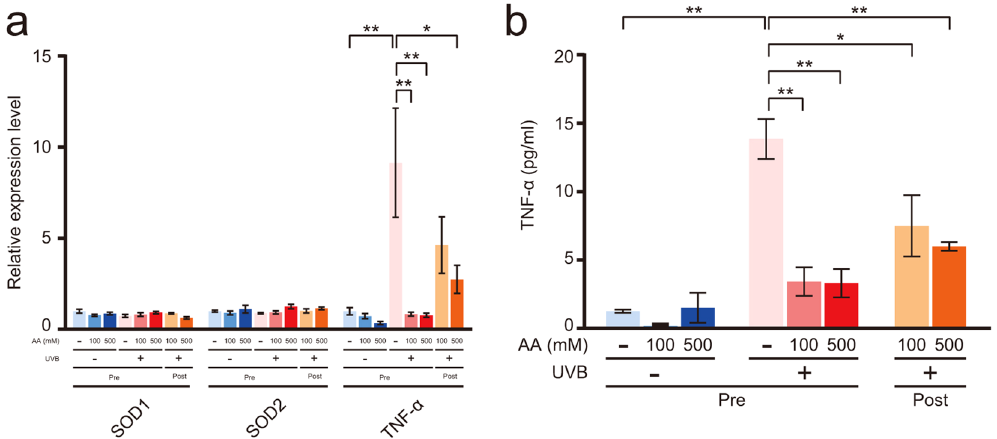
Figure 6. Effects of AA on UVB-induced gene expression and TNF- α production. ( a ) The reconstituted human epidermal surface was treated with 100 and 500 mM AA for 3 h before or after 120 mJ/cm 2 UVB irradiation. After UVB irradiation, the epidermis was cultured for 3 h. Levels of the SOD1, SOD2, and TNF- α mRNAs were analysed by qPCR. The 18 S rRNA was used as the endogenous control gene. Values are presented as the means ± SEM of three wells. ( b ) After UVB irradiation, the epidermis was cultured for 9 h. The amount of TNF- α in the medium was measured by ELISA. Values are presented as the means ± SEM of three wells. The statistical analysis was performed using one-way ANOVA followed by Tukey’s post hoc test. * P < 0.05, ** P < 0.01. Pre, AA treatment before UVB irradiation. Post, AA treatment after UVB